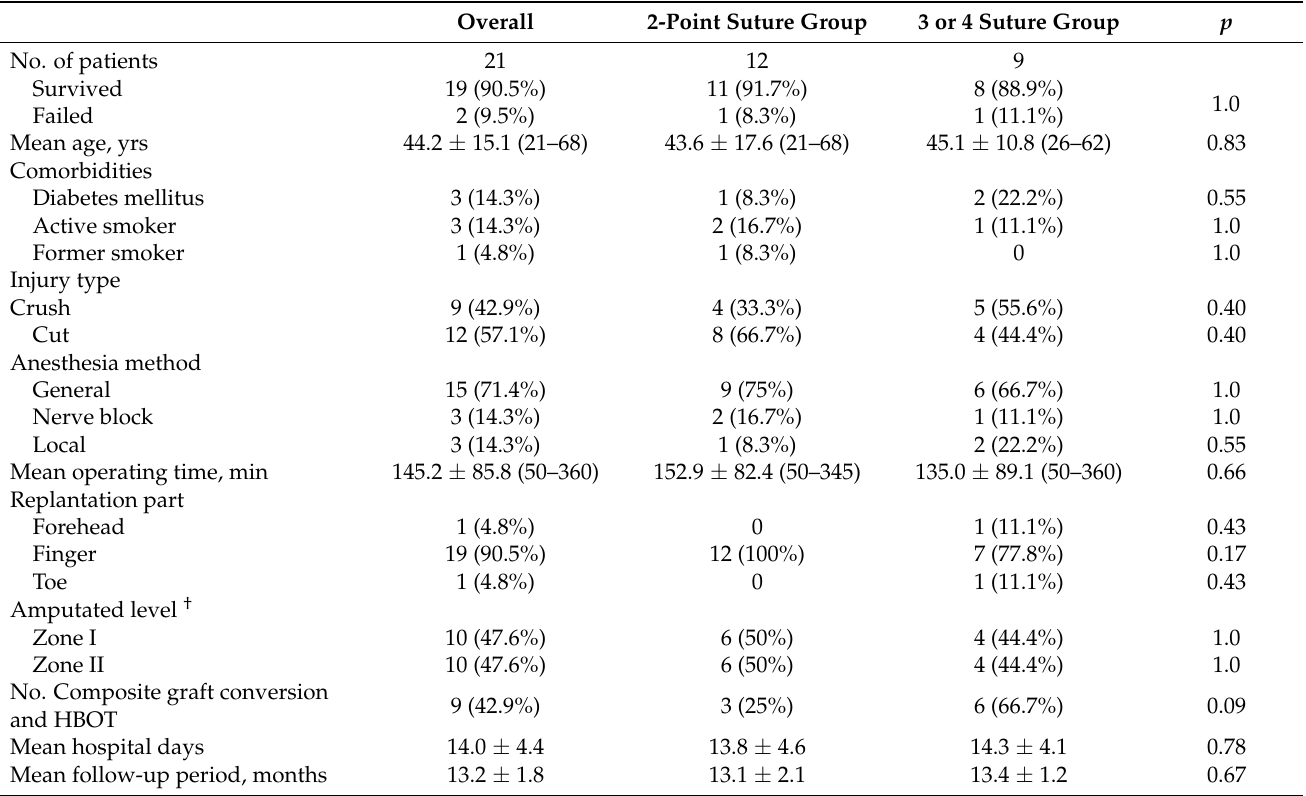
Table 1. Summarized patient and operative data *.